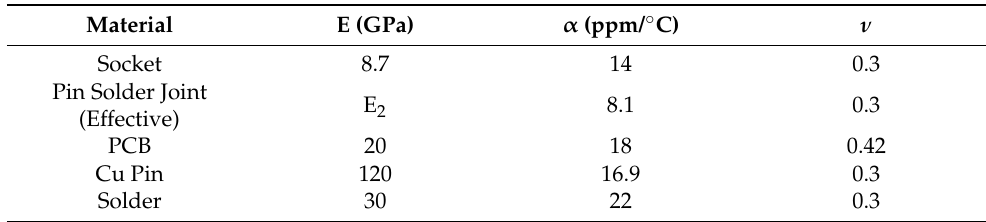
Table 1. Material properties for the theoretical analysis and FEM simulation. (Note: The α for the socket and PCB and the E for the socket were measured in this study, while the rest of them except for E 2 were provided by material